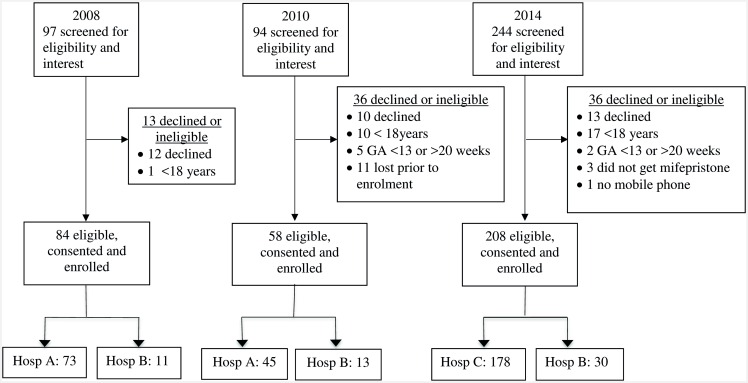
Participant recruitment to 2008, 2010 and 2014 cohorts.